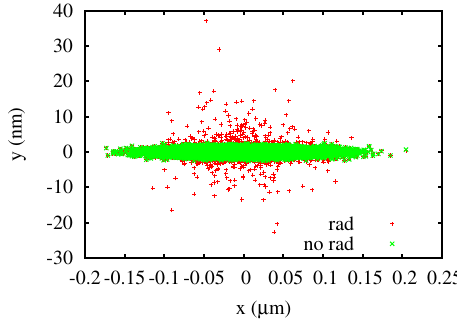
FIG. 5. CLIC 3 TeV beam at the IP after tracking through QD0 with and without